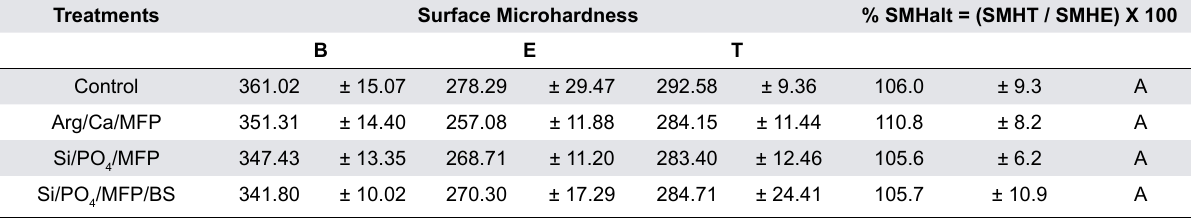
Table 2- Mean percentage (Standard deviation) of microhardness data and results of Tukey test for